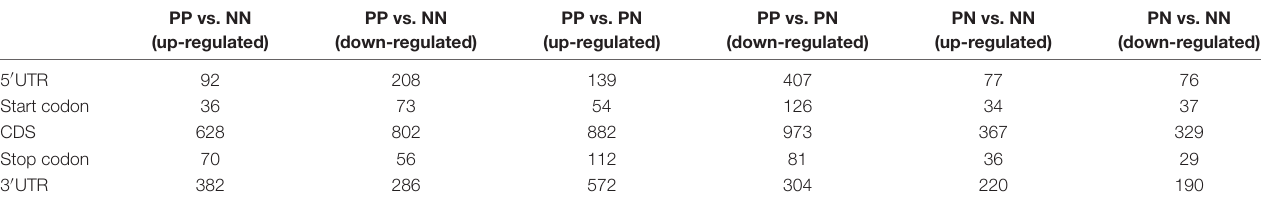
TABLE 1 | Number of m 6 A peaks among PP, PN, and NN samples.